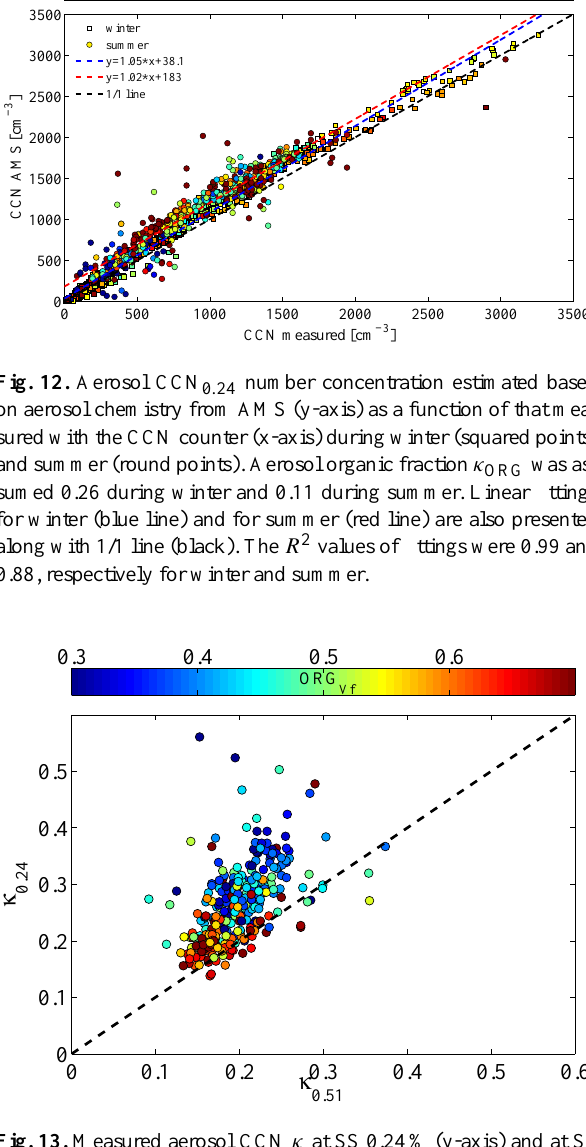
Fig. 13. Measured aerosol CCN κ at SS 0.24% (y-axis) and at SS 0.51% (x-axis), taken from the consecutive CCN measurements at the two SS, as a function of the organic volume fraction (colour scale) derived from the AMS total aerosol composition during sum- mer